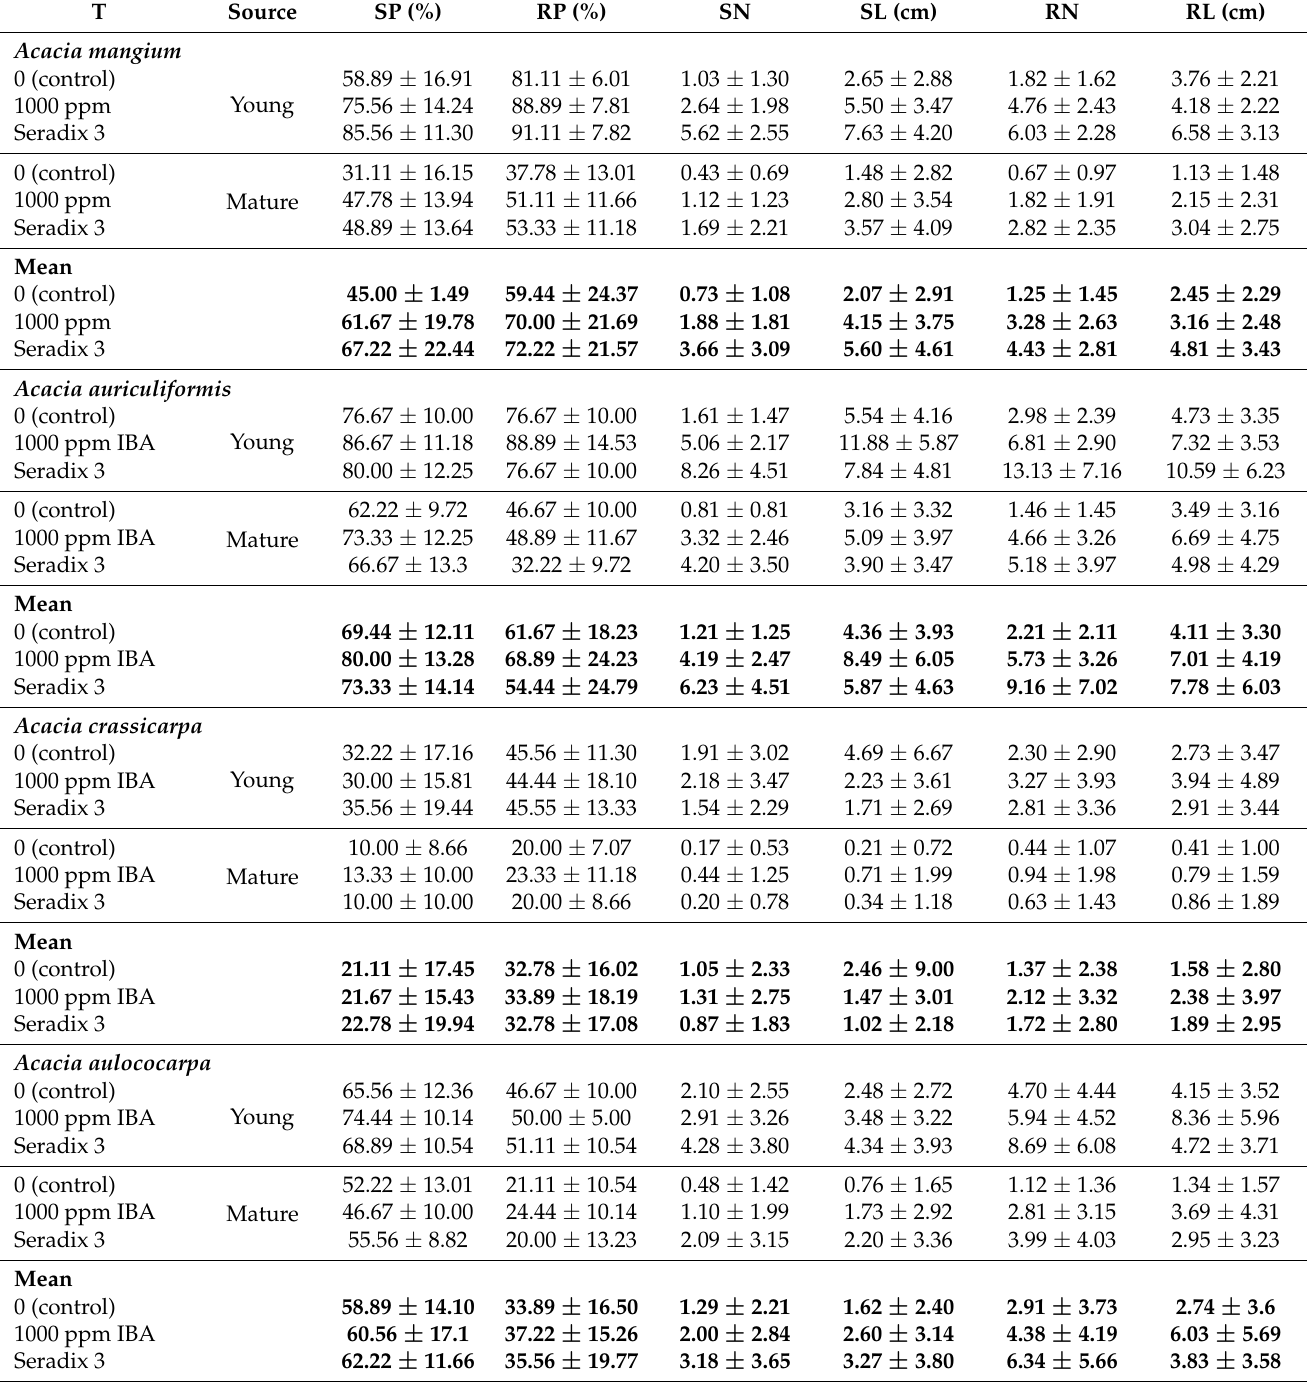
Table 7. Mean values of some rooting ability traits of hormone-treated cutting sources of four Acacia